Question: What kind of plot is shown here?
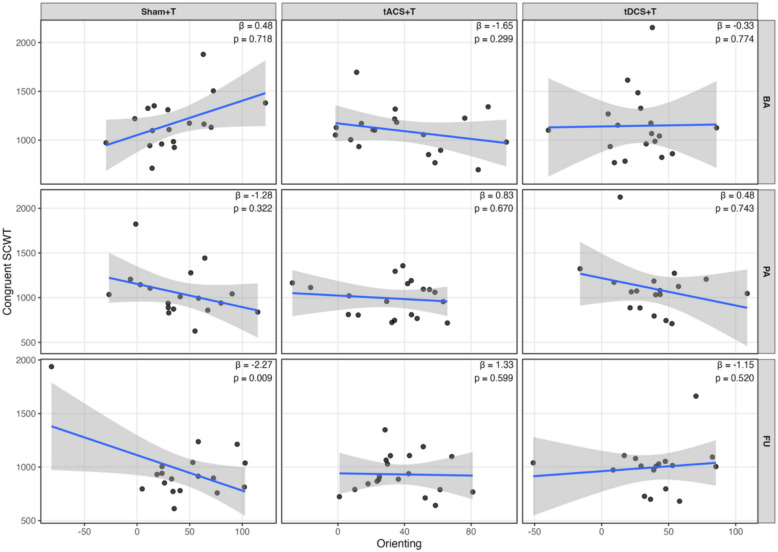
Answer: scatter